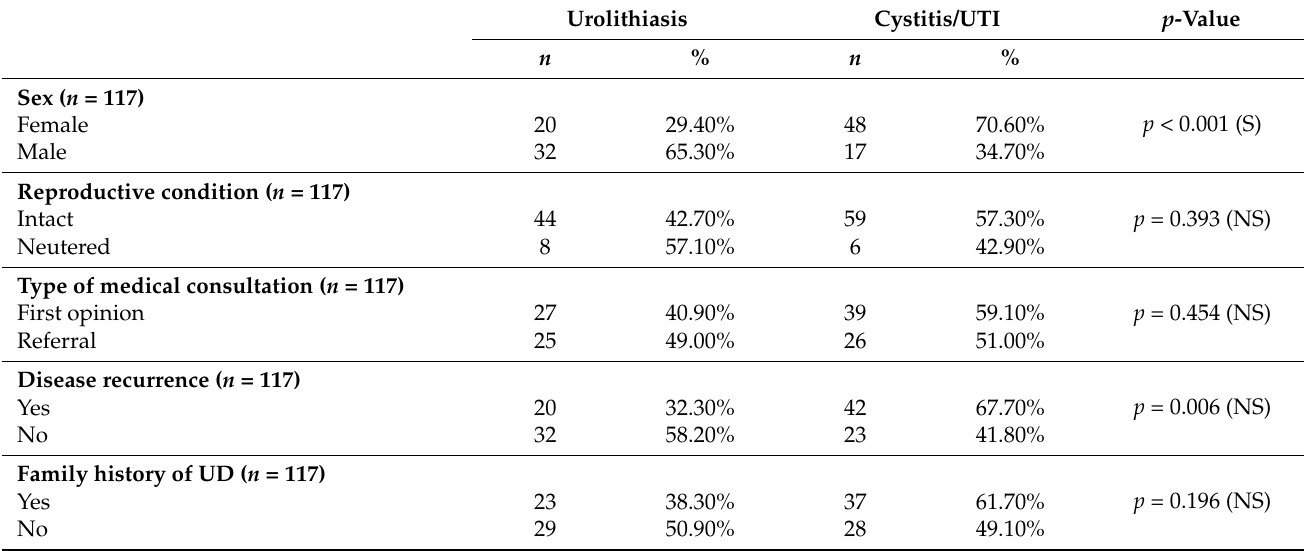
Table 2. Association between patient and diagnostic features with the guinea pigs’ diagnosis (urolithi- asis, cystitis, and/or UTI) in 117 clinical cases diagnosed with lower urinary tract